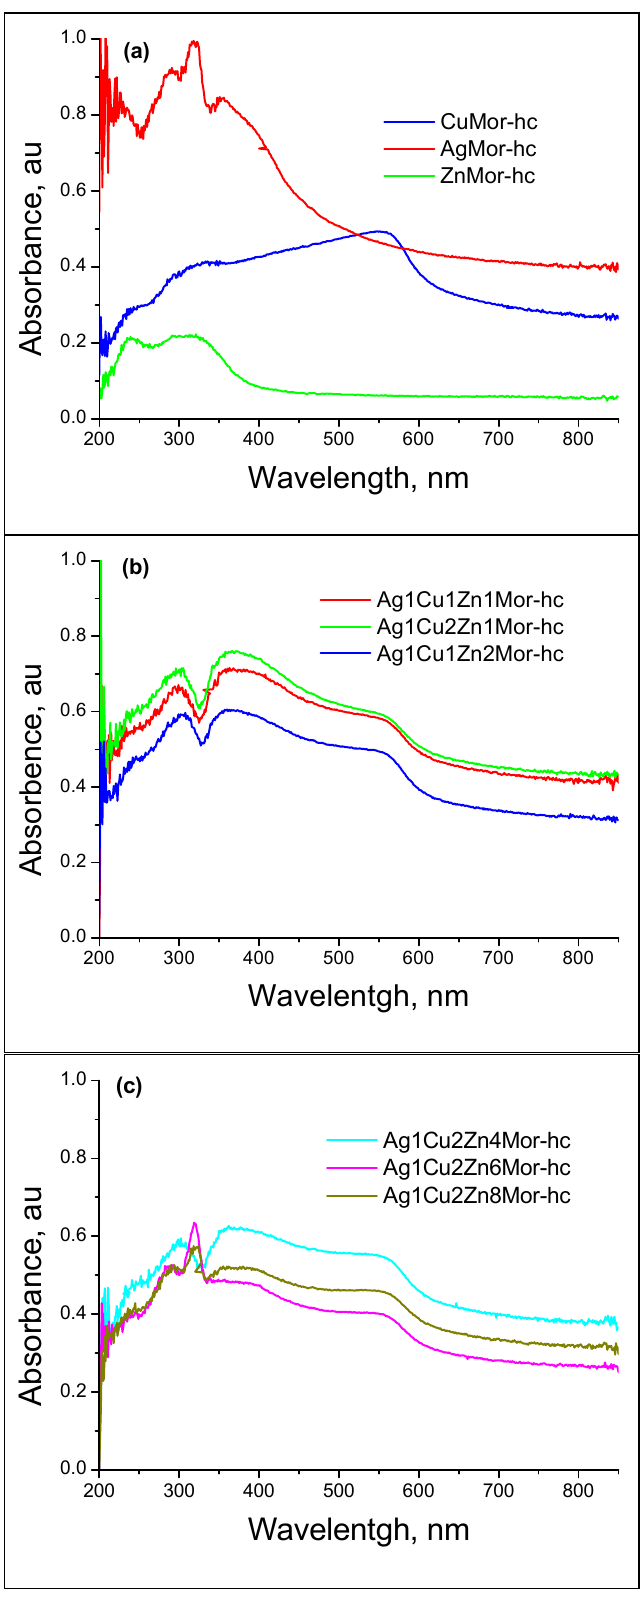
Figure 7. UV-Vis diffuse reflectance spectra of the samples reduced and then cooled in hydrogen.